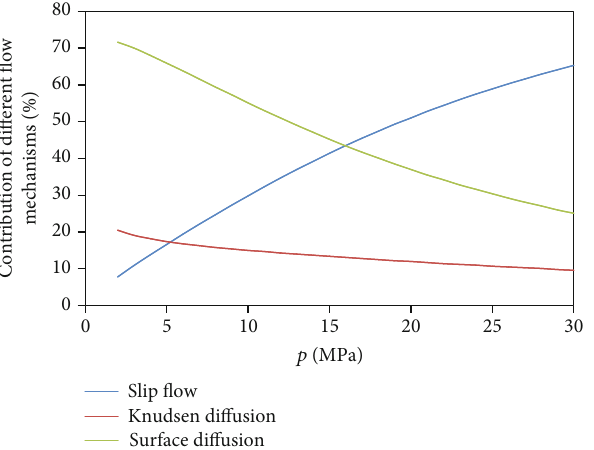
Figure 7: The impact of stress sensitivity and adsorption layer on apparent permeability.